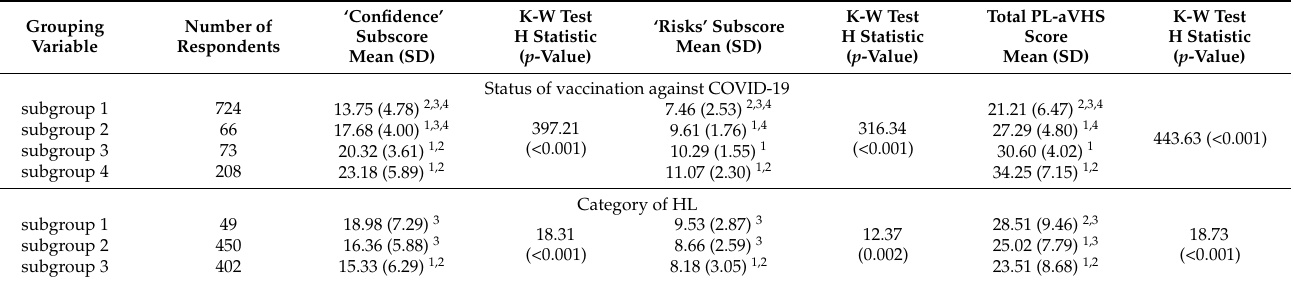
Table 6. The differences in the subscores and total PL-aVHS score between subgroups distinguished according to COVID-19 vaccination status and the level of